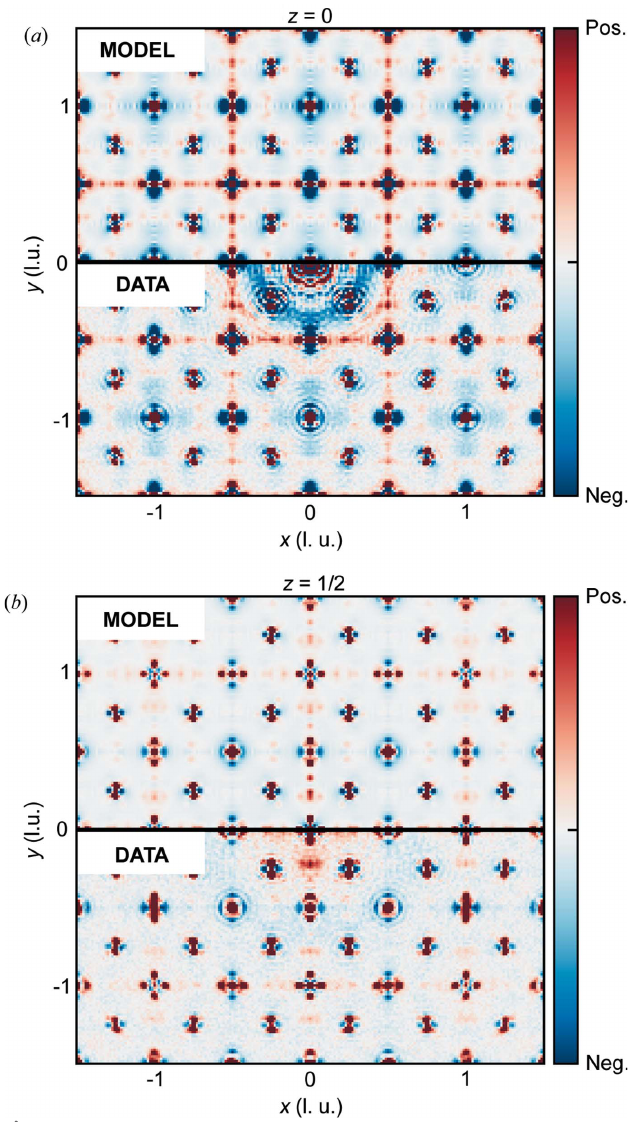
Figure 4 Modelled and experimental 3D- (cid:2) PDFs in the ( a ) z = 0 plane and ( b ) z = 1/2 plane (fractional coordinates of the bixbyite unit cell). The data are shown on an arbitrary scale.